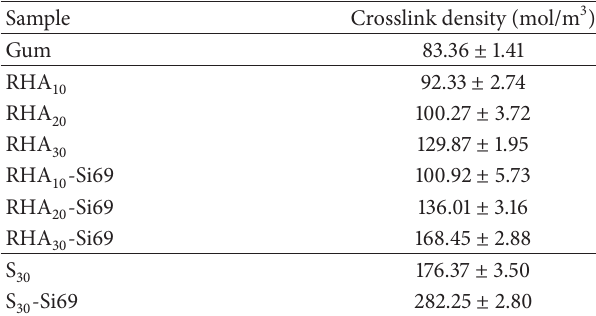
Table 6: Crosslink densities of gum and filled ENR-25 vulcanizates with various RHA contents and 30 phr of silica with and without silane coupling agent